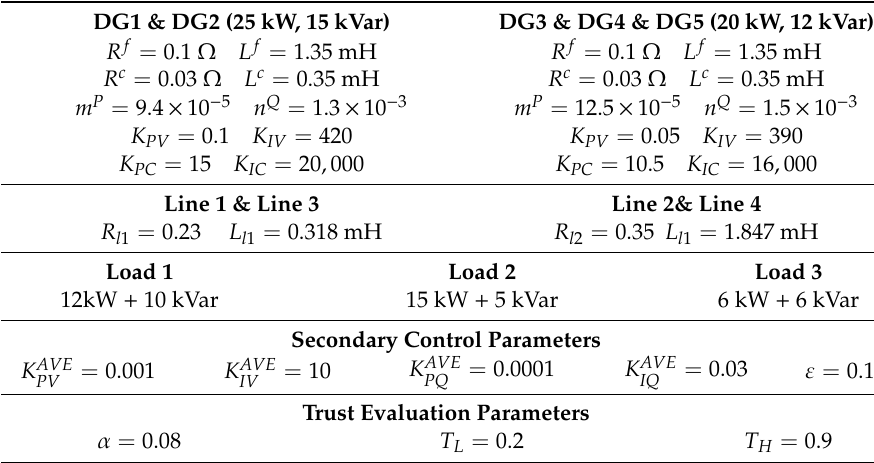
Table 1. Parameter values for simulation.